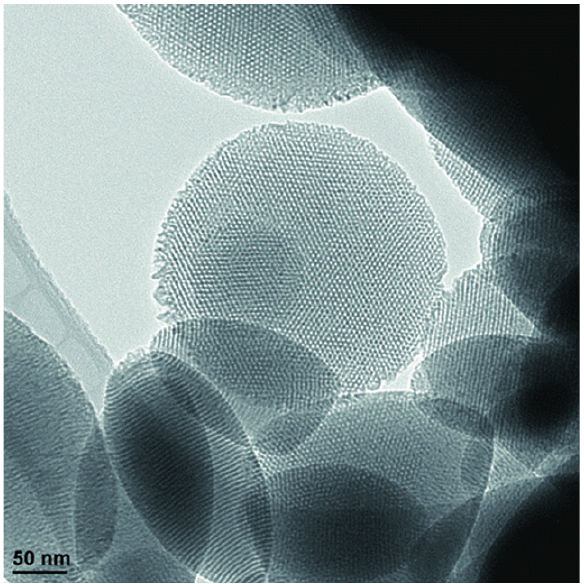
Figure 2 Sample TEM image of mesoporous silica nanoparticles [4] . Reprinted with permission from Ref. [4] . Copyright (2007) American Chemical